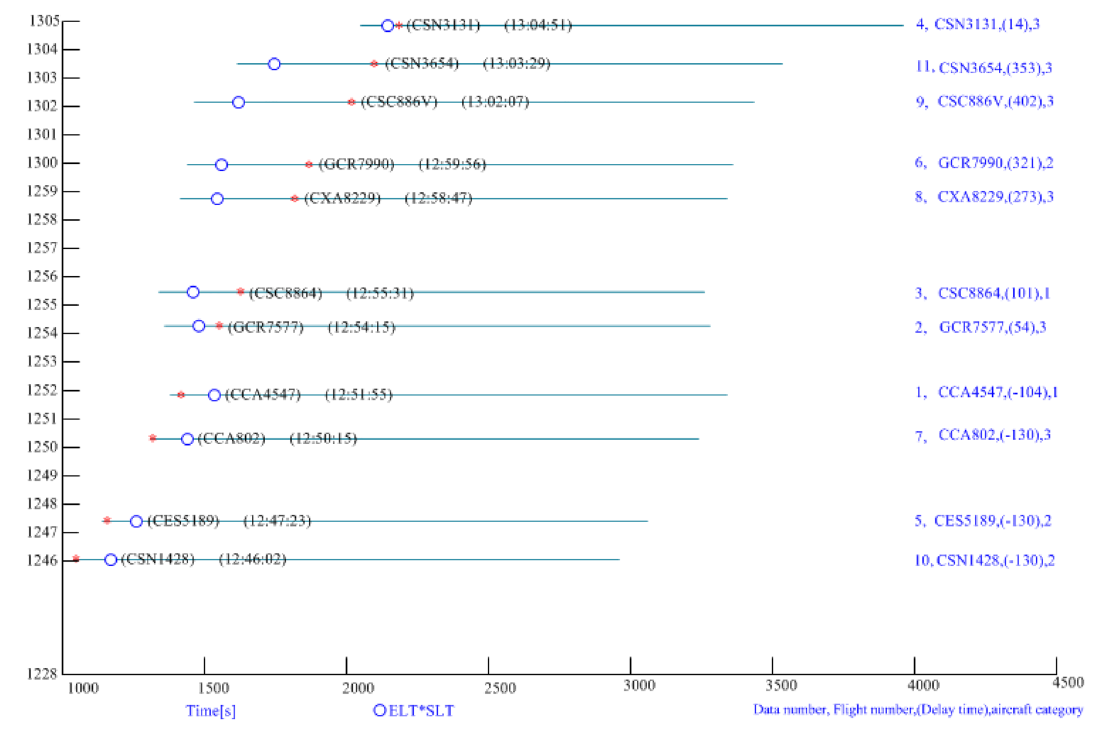
Fig. 3 The arrival sequence and the scheduled landing instant of SA